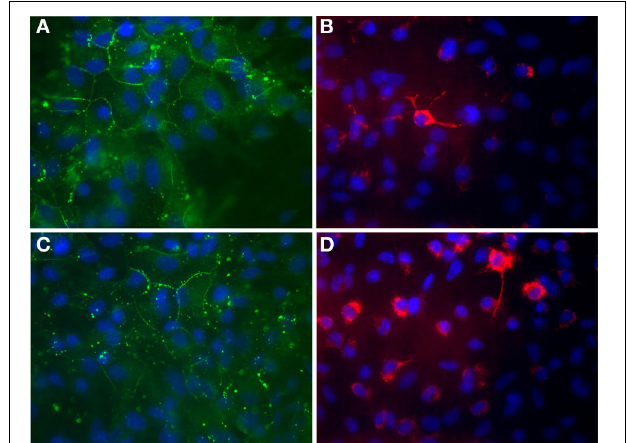
FIGURE 1 | Immunocytochemical labeling of Cx43 expression (A,C) and ED-1 positive cells (B,D) of astroglia/microglia co-cultures. (A,B) Astrocytes co-cultured with about 5% microglial cells in order to mimic physiological brain tissue. (C,D) Astrocytes co-cultured with about 30% microglial cells in order to mimic inflammatory affected brain tissue. Glial cells were counterstained with DAPI to visualize the nuclei (blue). (A) Astroglial Cx43 Expression (green) under physiological mimicked in vitro condition. (B) Microglia (red) are mostly found as inactivated, resting ramified type under physiological condition. (C) Astroglial Cx43 Expression (green) under inflammatory mimicked in vitro condition. The Cx43 protein level is reduced in those cultures. (D) Microglia (red) proliferate and change their phenotype to a round activated form under inflammatory condition. This process could also be observed under in vitro conditions in cultures. 63x